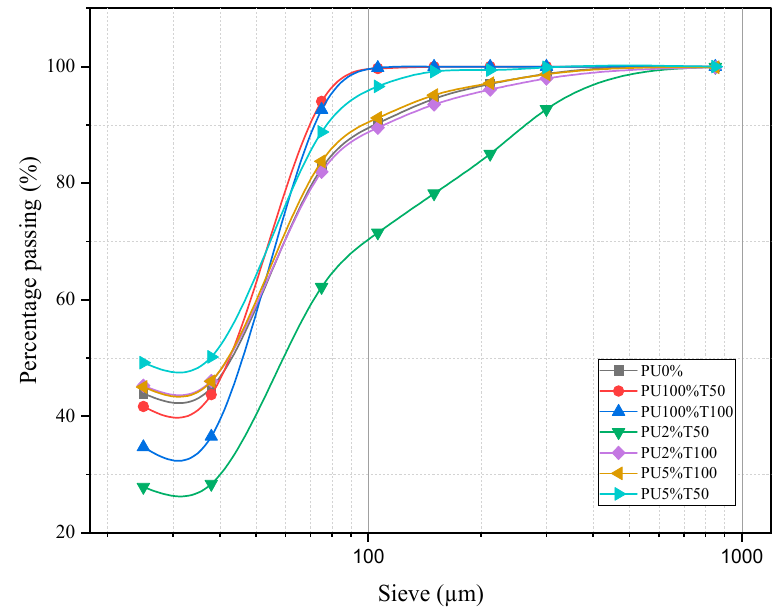
Figure 4. Granulometry profile of PU and polyurea mortar samples. The samples with a similar profile to that of PU0% were those using polyurea retained in sieve 100. This is because the smaller particles were conducive to the granulometry not being affected. In contrast, the samples using polyurea retained in sieve 50 presented different behaviors according to the concentration, obtaining curves above and below that of the control mortar when the concentrations were higher and lower, respectively. It is well known that the surface area of particles allows interactions between components. Figure 5 reveals that the samples presenting a greater dispersion of the particles presented a lower resistance with a certain linearity. In the case of samples retained in sieve 50, a greater dispersion can be observed in the PU2%T50 sample with respect to the PU5%T50 sample, a behavior that was not replicated in the PU2%T100 and PU5%T100 samples.